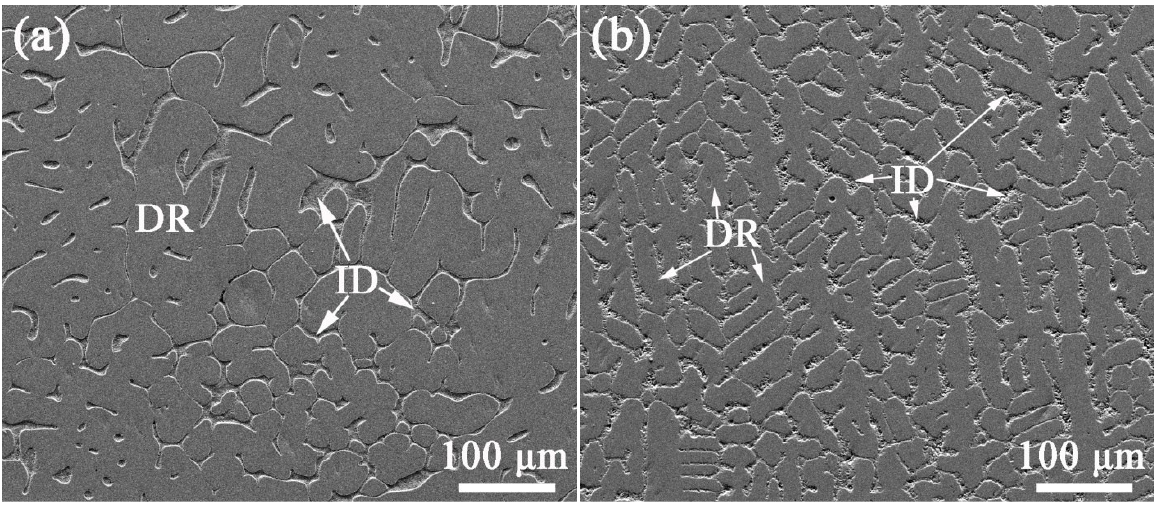
Figure 2. SEM secondary electron images of the ( a ) TiZr 0.5 NbCr 0.5 ; ( b ) TiZr 0.5 NbCr 0.5 V; ( c ) TiZr 0.5 NbCr 0.5 Mo